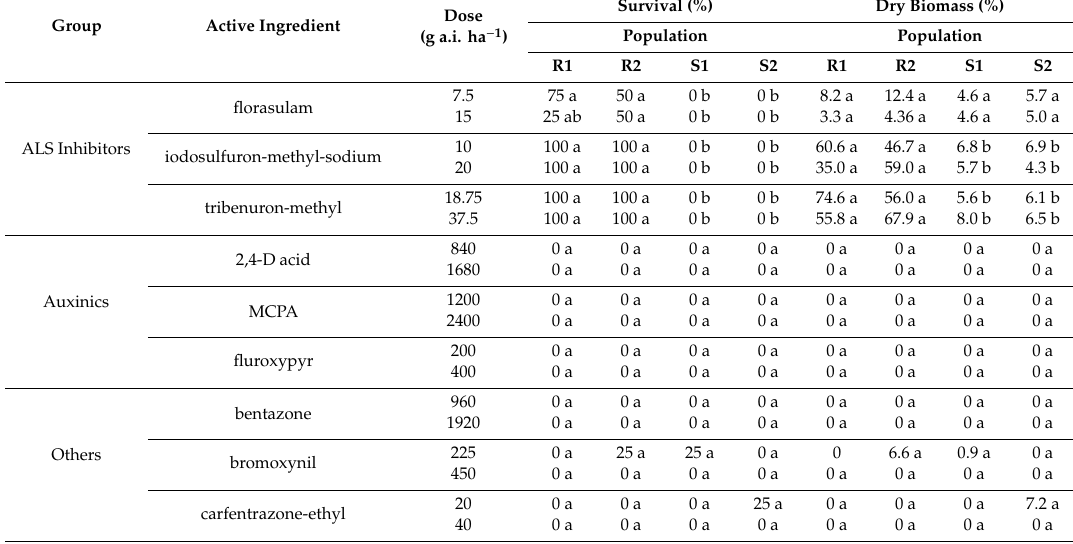
Table 5. Survival and dry biomass calculated based on those of the untreated control depending on the Rapistrum rugosum population and on the applied herbicide doses (active ingredient in g ha –1 ) for available herbicides in winter cereals. Rows with di ff erent letters for each dose and for each parameter correspond to statistically significant di ff erences following Tukey’s test ( p < 0.05). Survival and biomass were determined 30 days after herbicide